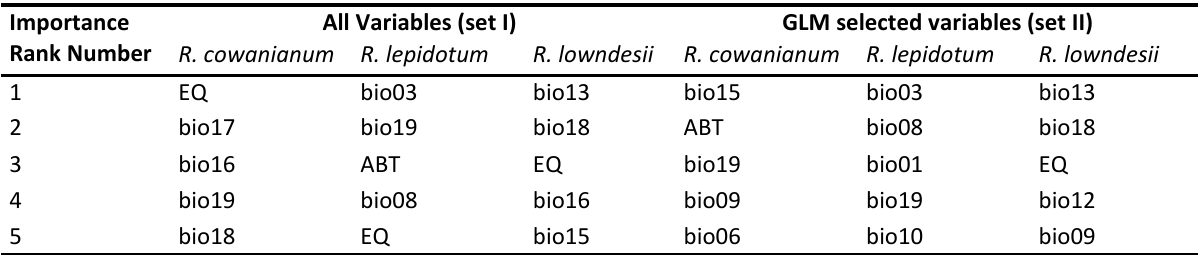
Table 1 . The most important variables for explaining the distributions of three Rhododendron species. Results from the model with presence data with random pseudo - absences using set I and set II variables.